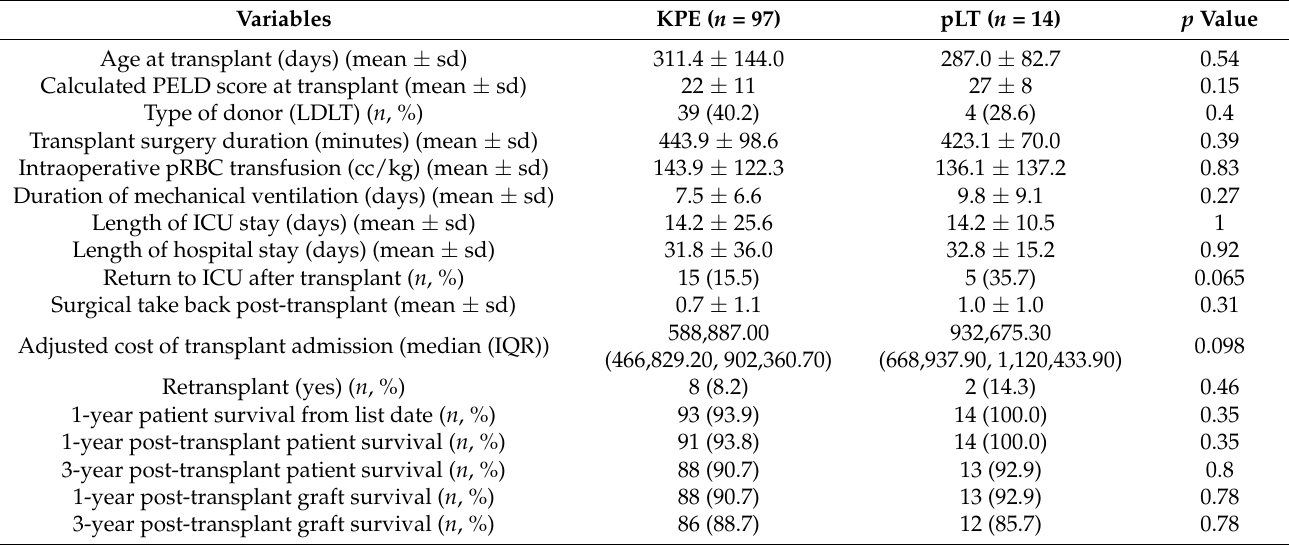
Table 2. Post-transplant comparison of patients transplanted after KPE or as pLT. Legend: PELD: Pediatric End-stage Liver Disease; LDLT: Living donor liver transplantation; ICU: intensive care unit.